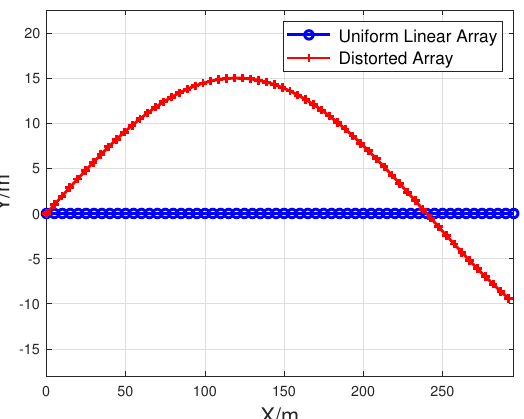
Figure 4. Hydrophone coordinates of the actual distorted array and the hypothetical uniform linear